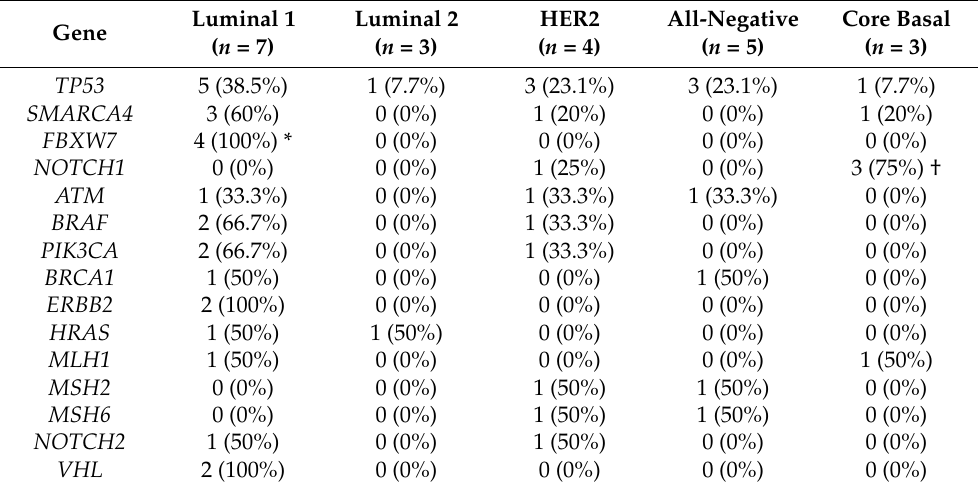
Table 3. List of genes with frequent pathogenic mutations according to the molecular subtypes.